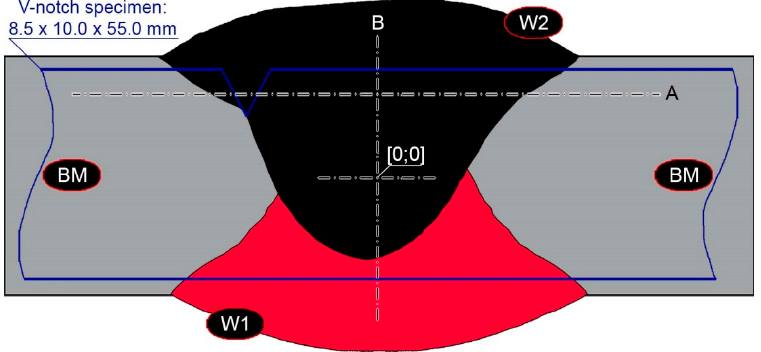
Figure 1. General diagram of a welded joint of Hardox 450. W1/W2—individual layers of the weld in accordance with the order of completion, A/B—lines of the executed hardness distributions, BM—parent material, the place of the V—shaped notch cut on the specimens for impact testing is schematically shown in